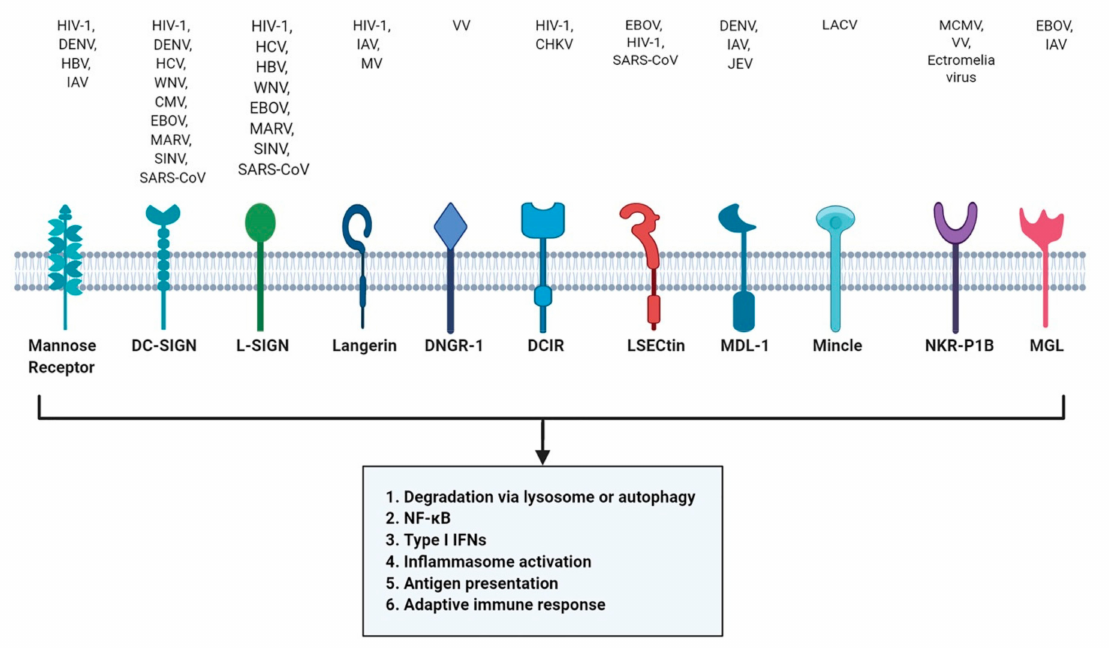
Figure 2. Recognition of viruses by C-type lectin receptors (CLRs). Upon recognition by CLRs, a signaling cascade is activated resulting in autophagy, NF- κ B activation, type I IFN production, antigen presentation, inflammasome activation and adaptive immune responses. HIV-1: Human immunodeficiency virus 1; DENV: Dengue virus; HBV: Hepatitis B virus; IAV: Influenza A virus; HCV: Hepatitis C virus; WNV: West Nile virus; CMV: Cytomegalovirus; EBOV: Ebola virus; MARV: Marburg virus; SINV: Sindbis virus; SARS-CoV: Severe acute respiratory syndrome-related coronavirus; MV: Measles virus; VV: Vaccinia virus; CHKV: Chikungunya virus; JEV: Japanese encephalitis virus; LACV: La Crosses virus; MCMV: Mouse cytomegalovirus; Ectromelia